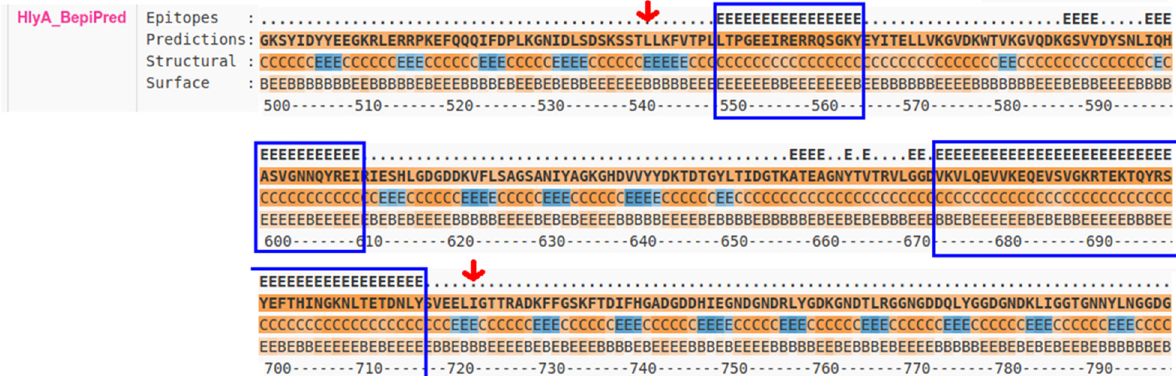
Figure 1. Prediction of epitopes by the BepiPred program. The predicted epitopes in HlyA are highlighted with blue rectangles. The arrows indicate the start and the end of the selected amino acid sequence for cloning and expression. E: an amino acid likely in an inferred epitope segment; H: α -helix; E: β -sheet; C: coil; B (and E in last line): buried/exposed. Table 1. Epitope prediction screening from the region (542 aa-723 aa) of alpha-hemolysin. Peptide Sequence